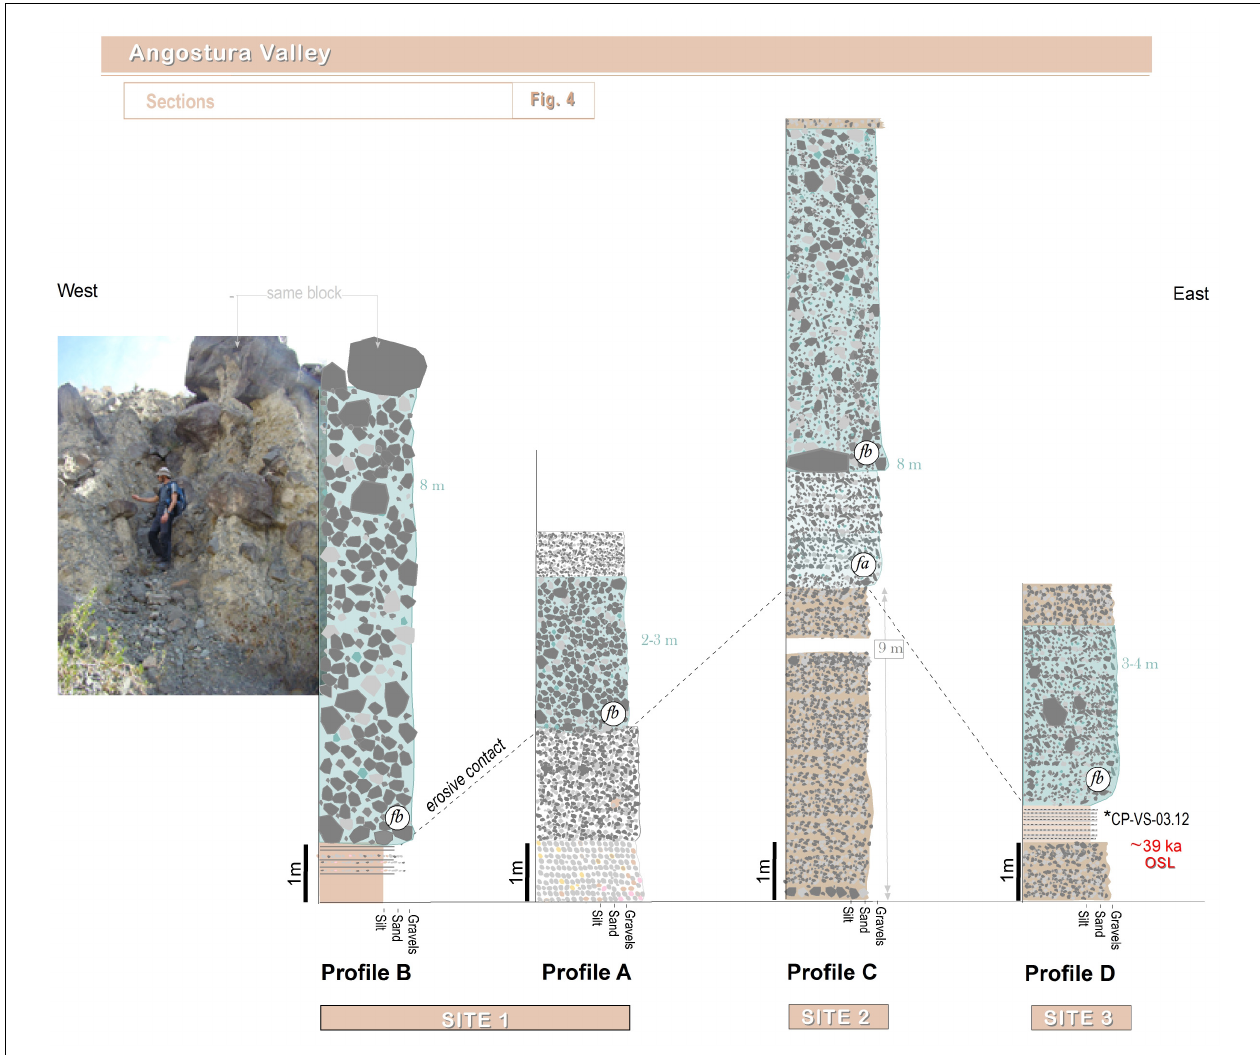
FIGURE 5 | Graph of sedimentological profiles described in sites 1, 2, and 3 along the Angostura Valley showing presence of facie a ( fa ) or facie b ( fb ) (see pictures in Figure 4 ). The photo on the left corresponds to the top of the profile B with a person as scale.